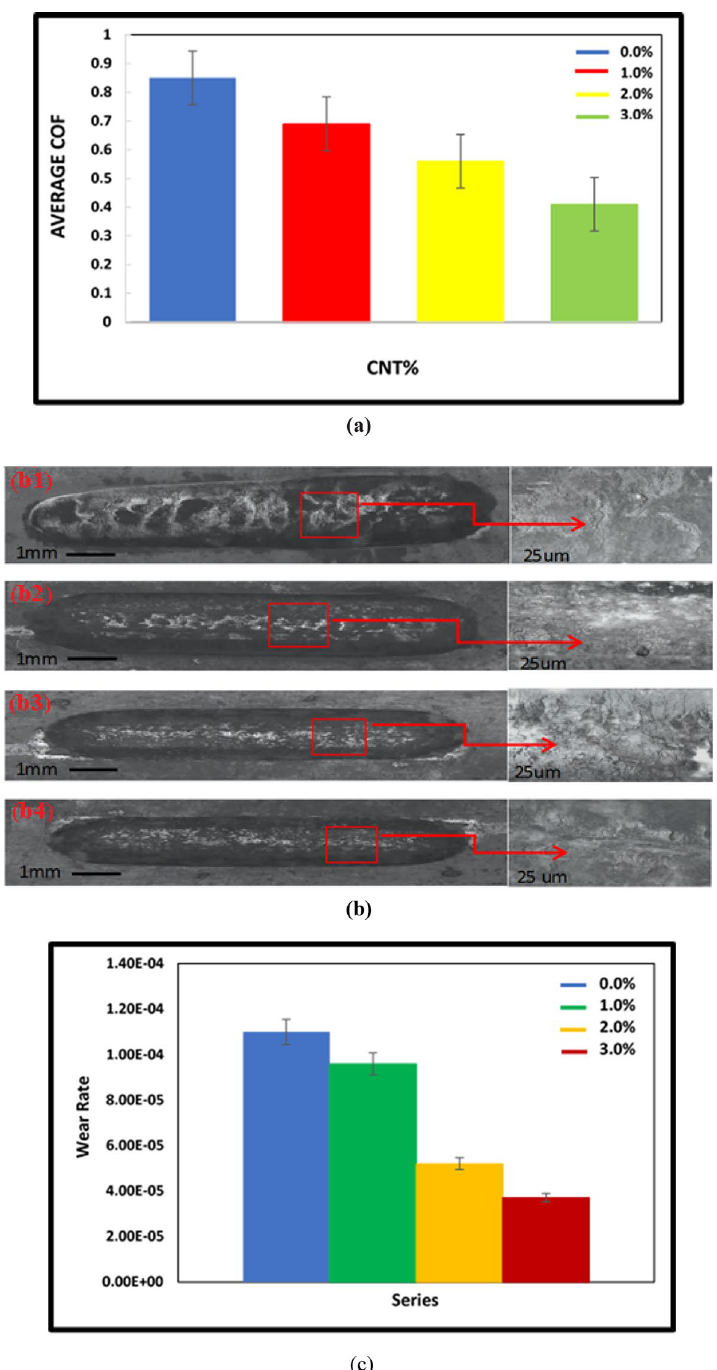
Figure 11. ( a ) Coefficient of friction of HA/TiO 2 /CNT 0%, 1.0%, 2.0%, and 3.0%, ( b ) Optical images of worn surface of the